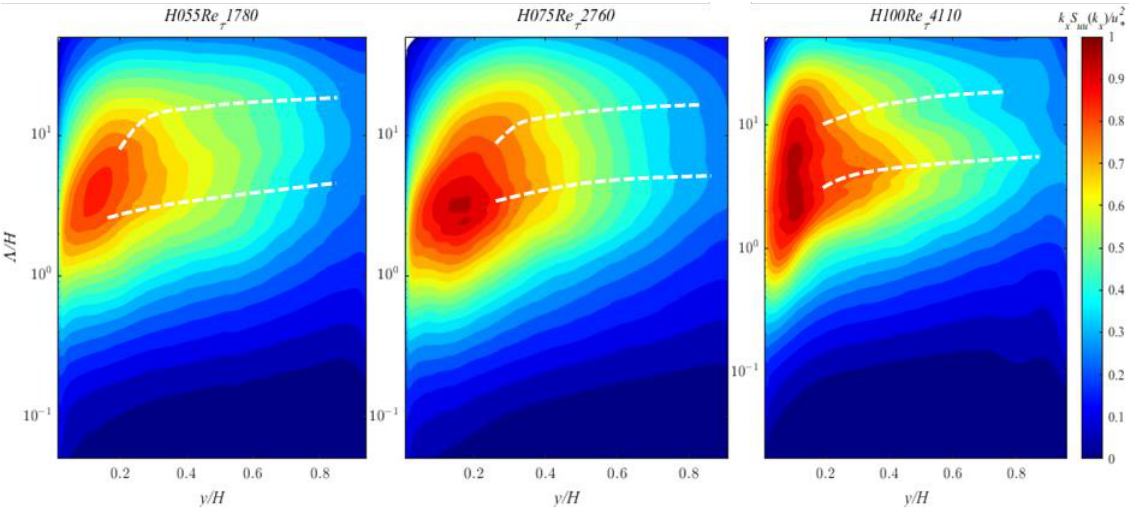
Figure 6. Pre-multiplied spectra of the streamwise velocity fluctuations. Double peaks corresponding to LSMs and VLSMs can be clearly seen in the pre- multiplied spectrum of the streamwise velocity fluctuation shown in Figure 6. The double- peak phenomenon of LSMs and VLSMs in the present irregularly arranged rough-bed OCF is similar to that in the smooth-bed OCF [26] and the regular rough-bed OCF [21]. The spectral footprints of both the LSMs and VLSMs under the three conditions extend beyond y/H = 0.8, which is a unique characteristic of OCF. The existence of a VLSMs peak in the pre-multiplied spectrum also meets the requirement of the standard wall flow friction Reynolds number (R τ >